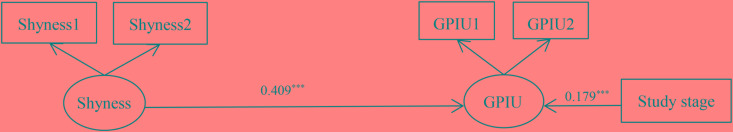
Total effect model. Path values are the path coefficients. ∗∗∗p < 0.001.